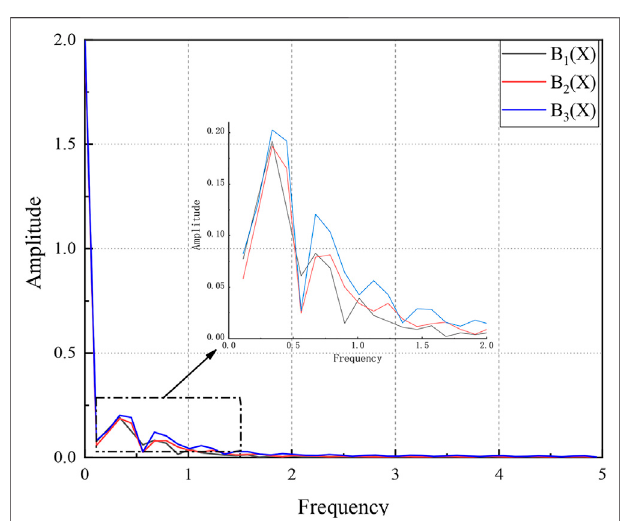
FIGURE 14 | Fourier transform plot of near- fi eld ( x /h (cid:1) 0) surge.